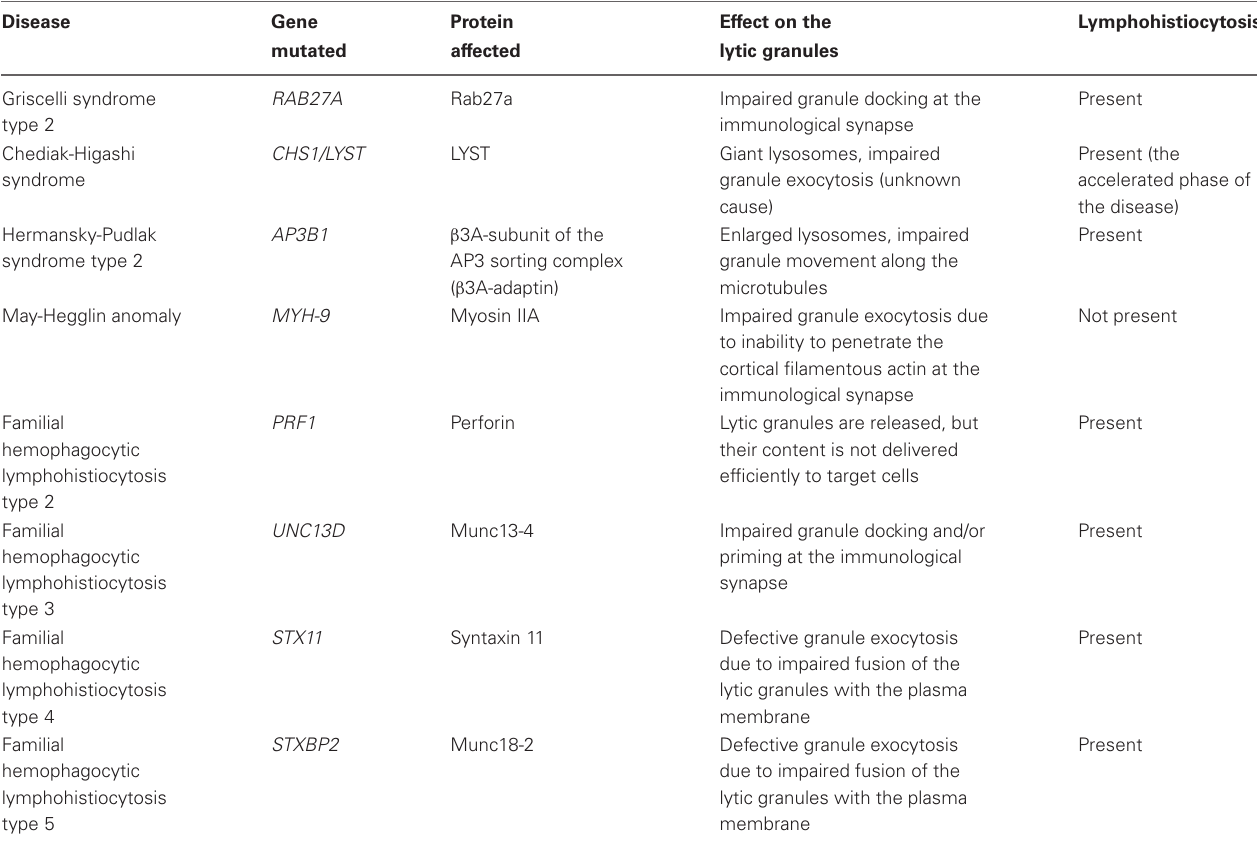
Table 1 | Human diseases linked to lytic granules and defective NK cell function.